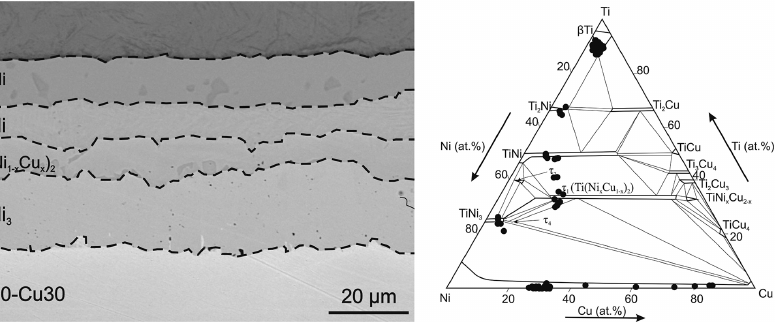
Figure 5: Left – the microphotography showing grown intermetallic phases, right – the diffusion path in diffusion couple experiment Ti-Ni70Cu30 at 1,123 K after 160